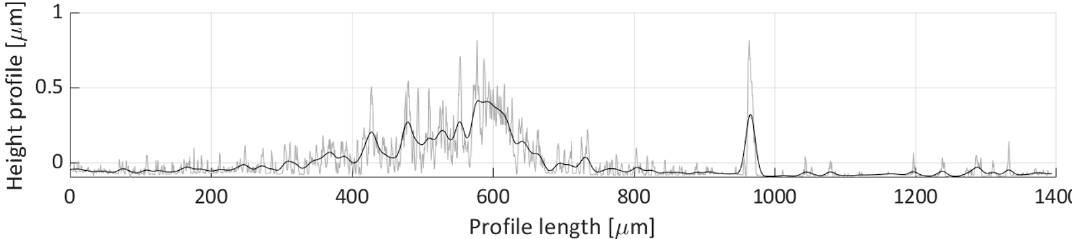
Figure 23. Height profile for the H3 line.